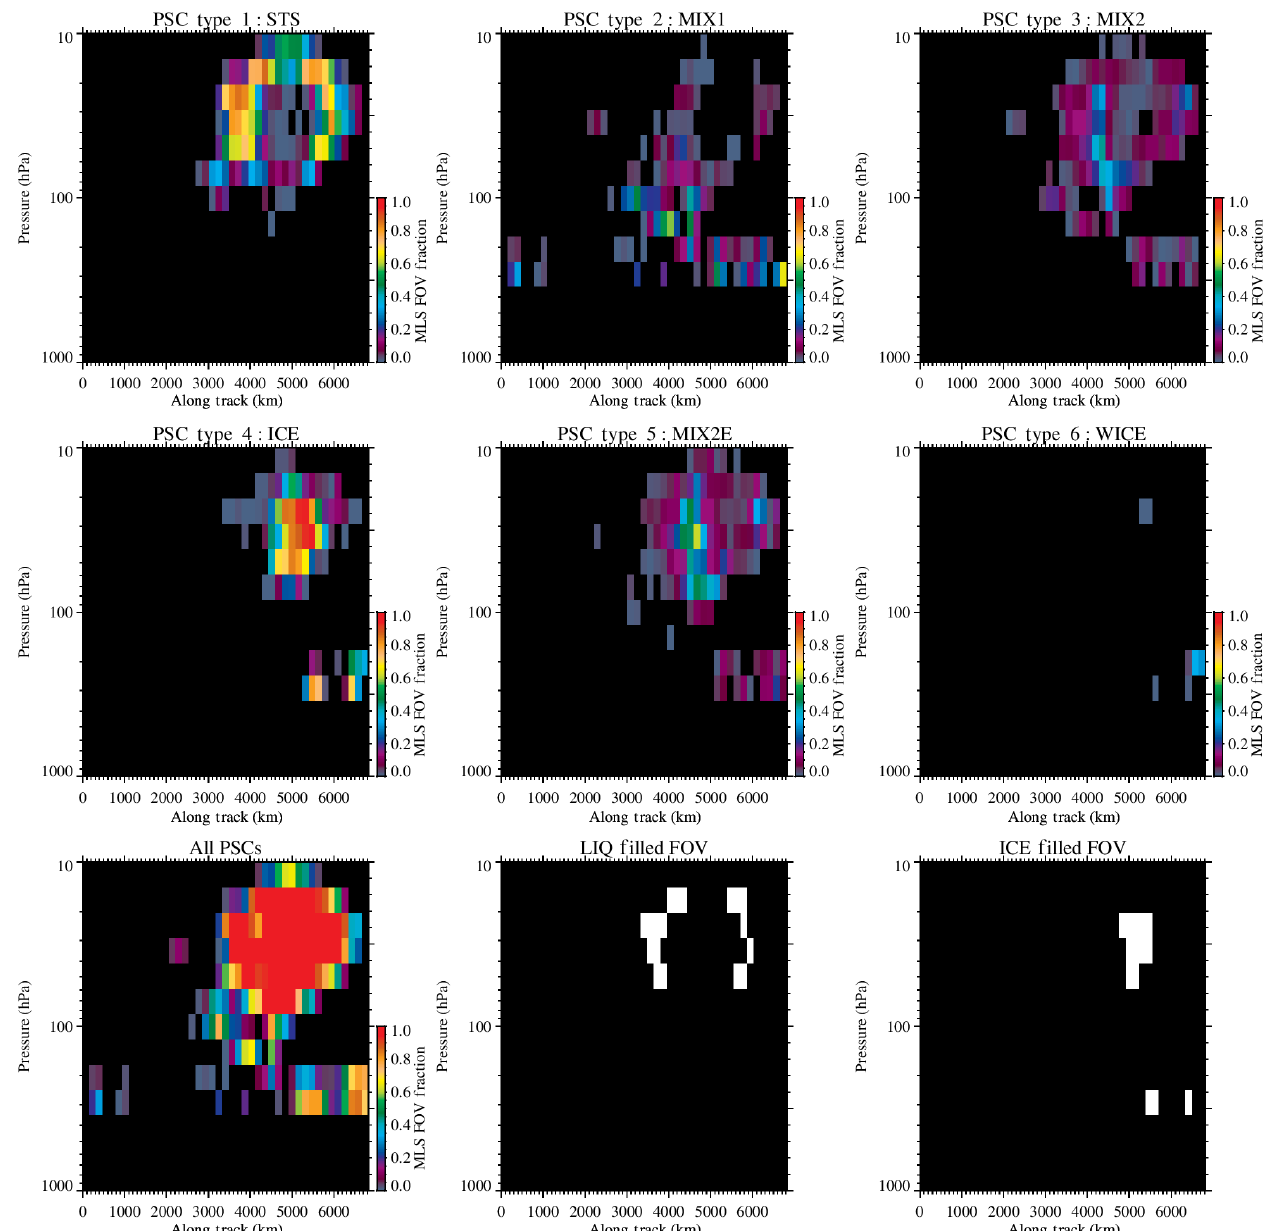
Figure 10. Orbit transect from Fig. 9 indicating the fraction of the MLS geometric FOV that is filled by each CALIOP classified PSC type and all PSCs. The white areas in the LIQ and ICE filled FOV plots indicate the locations that pass the strict FOV filling criteria given in the